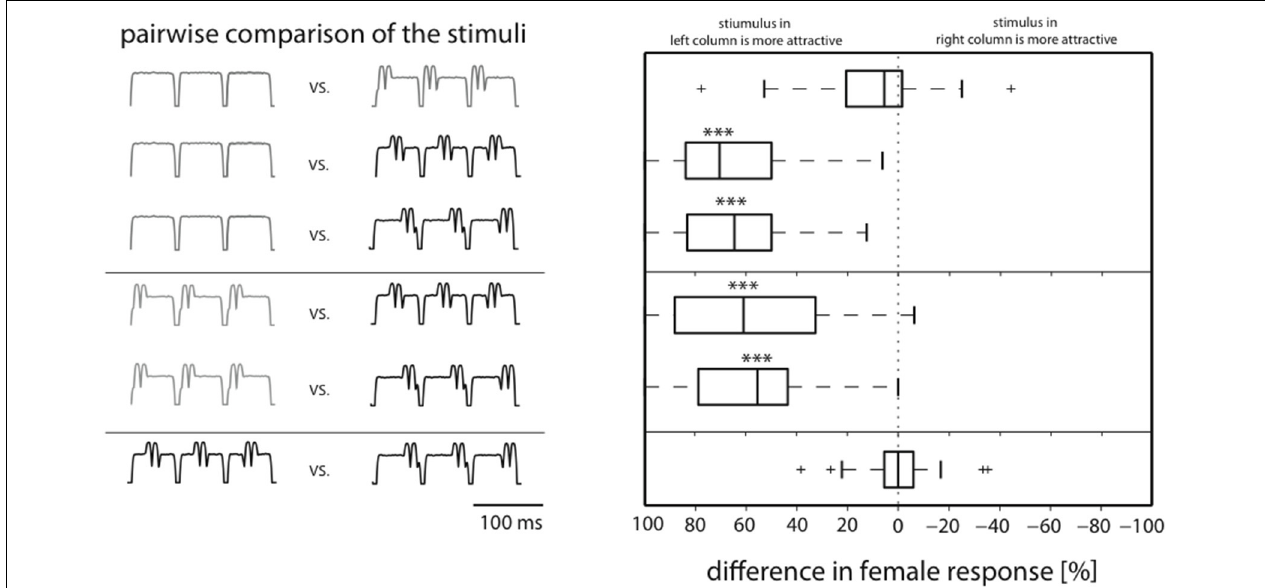
FIGURE 2 | Pairwise comparison of individual female responses allows distinction in attractive and unattractive stimulus classes. Box plots show medians of response differences in individual females for stimulus comparisons shown in the left. Whereas there